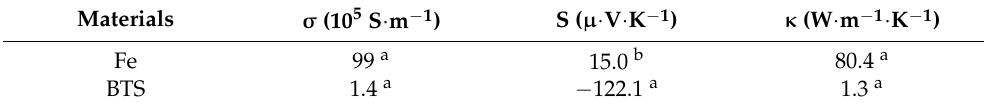
Table 1. Room-temperature transport parameters of Fe and BTS.